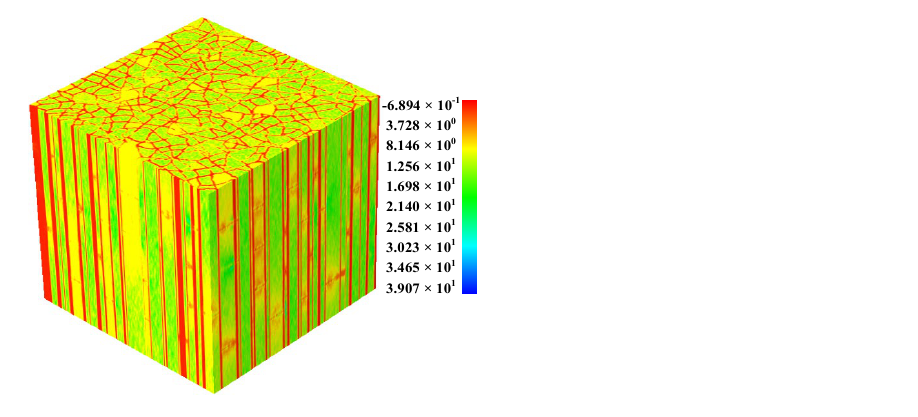
Figure 13. The maximum principal stress distribution; the unit is MPa. Appl. Sci. 2022 , 12 , x FOR PEER REVIEW 22 of 30